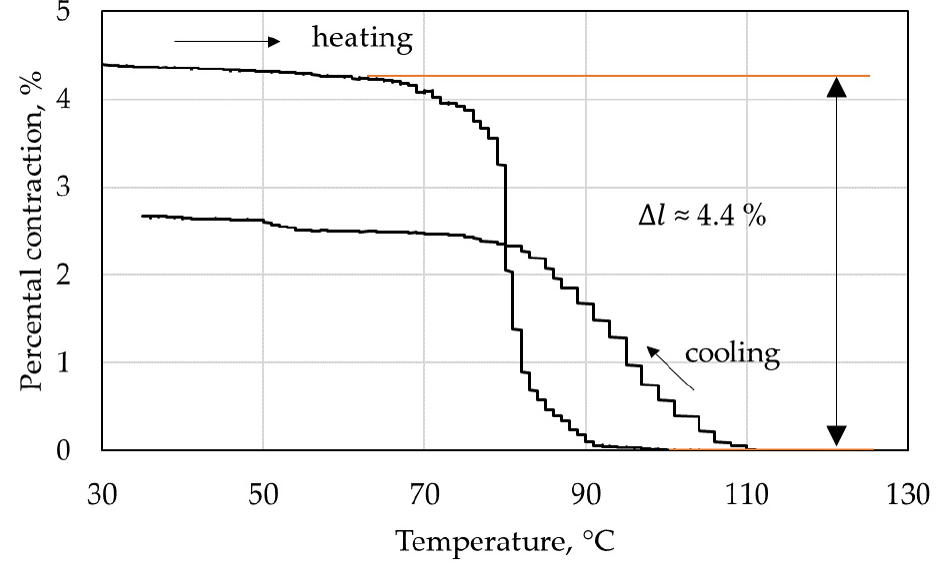
Figure 13. UPFR test of the SMA wire material.